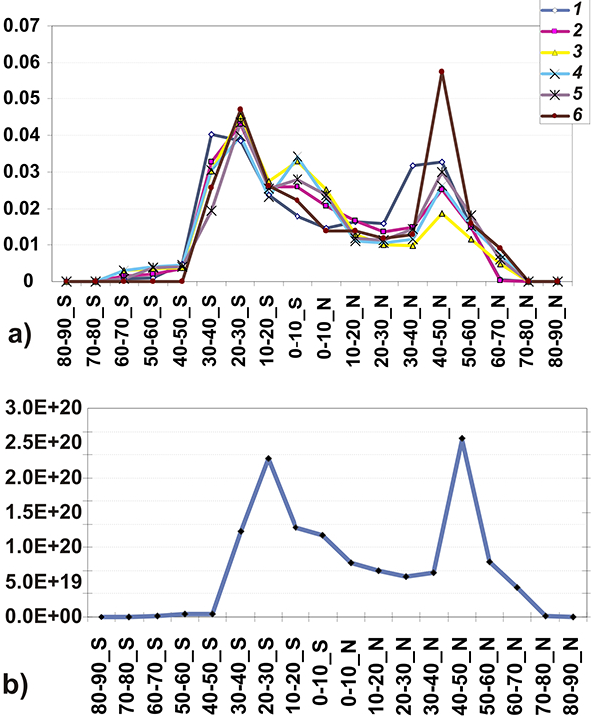
Fig. 2. (a) Distributions of the relative seismic event density (the ˆ Np i,k values) over latitude belts for 6 magnitude ranges: 1 for 4 . 0 ≤ M < 4 . 5, 2 for 4 . 5 ≤ M < 5 . 0, 3 for 5 . 0 ≤ M < 5 . 5, 4 for 5 . 5 ≤ M < 6 . 0, 5 for 6 . 0 ≤ M < 6 . 5, and 6 for 6 . 5 ≤ M . (b) The distribution of the energy density (the Ep i values) over latitudinal belts.